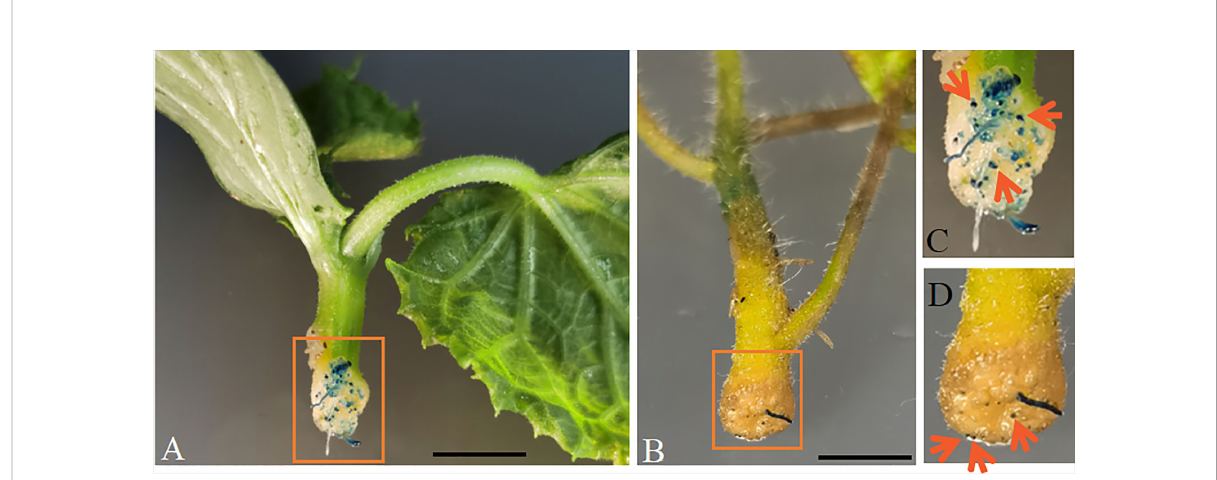
FIGURE 4 AtGCSpro 1178 activity assay in other dicots hairy roots by ARM transformation. Cucumber (A) and tomato (B) transformed with AtGCSpro 1178 :: GUSPlus. GUS signal can be observed in the region where will produce transgenic roots (Shown by orange arrows in (C and D) (C, D) . Pictures C and D are closed-up of sections (A, B) marked in the orange boxes, respectively. All composite plants were observed from 16-day-old post- infected seedlings with K599 carrying p AtGCSpro 1178 :: GUSPlus . Bars = 1